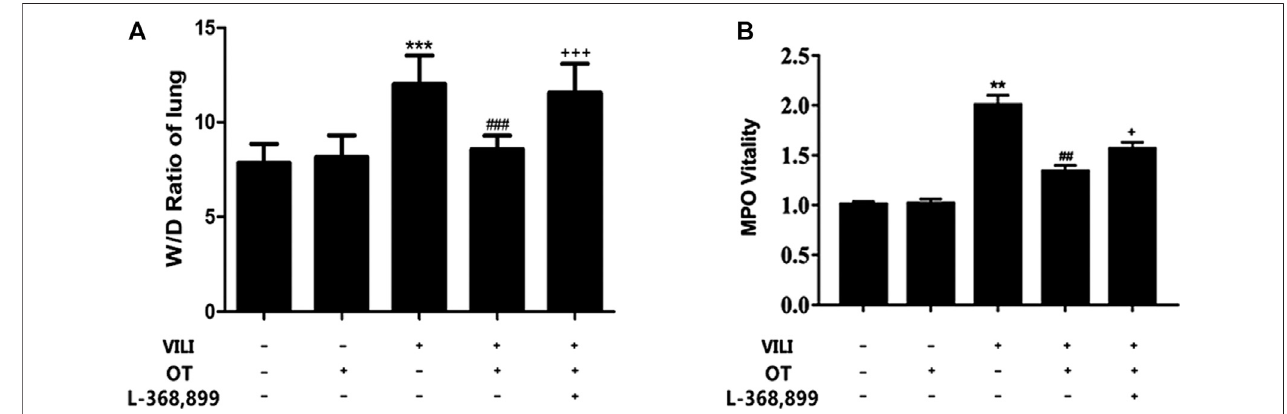
FIGURE 3 | Oxytocin attenuated the lung wet/dry ratio and myeloperoxidase activity.Effects ofOT on the lung W/D ratio (A) and MPO activity (B) are presented as themeans ± SD.* p < 0.05, ** p < 0.01compared withtheControland Control+OTgroups; # p < 0.05and ## p < 0.01compared withtheVILIgroup. + p < 0.05and ++ p < 0.01 compared with the OT + VILI group ( n (cid:2) 5). MPO, myeloperoxidase; OT, oxytocin; SD, standard deviation; VILI, ventilation-induced lung injury.